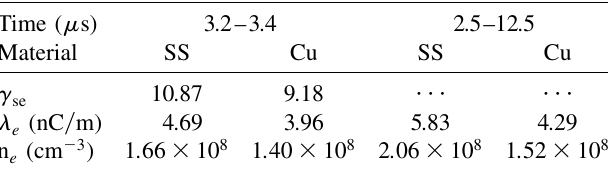
TABLE III. Calculated secondary emission coefficient and electron densities immediately after the beam head